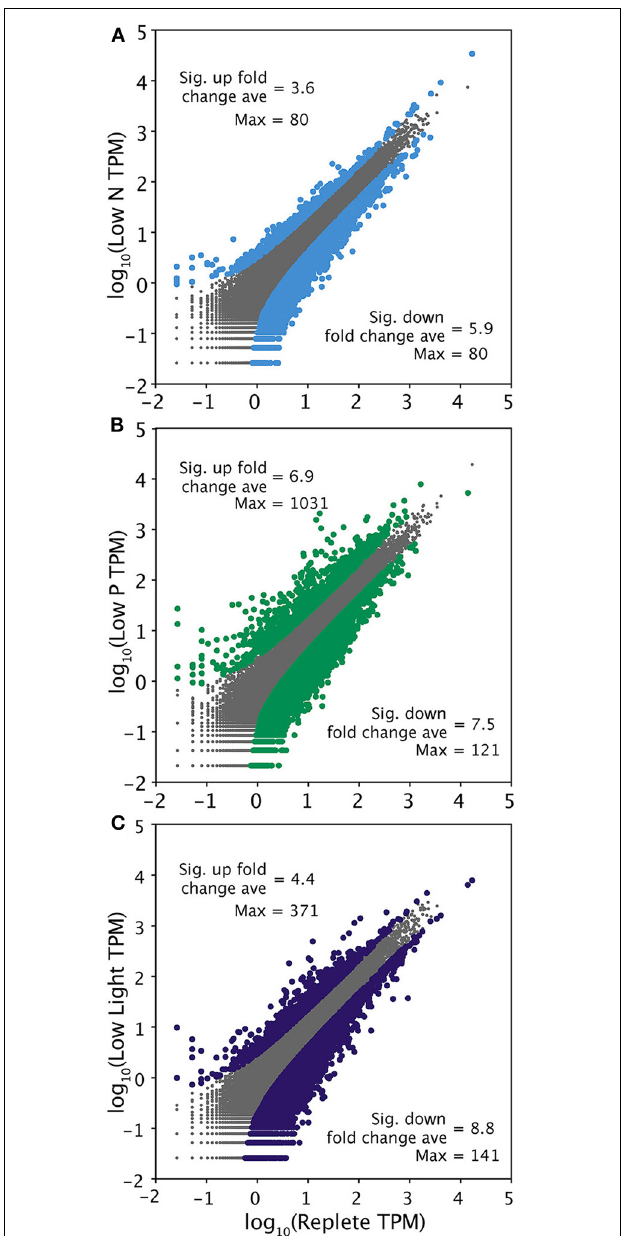
FIGURE 2 | Pairwise comparison of transcriptional responses across 37,314 contigs generated by a 90% clustering of the Trinity assembly in each treatment relative to the replete control. Transcriptome-side gene expression patterns are shown in low N (A) , low P (B) , and low light (C) . Transcripts were normalized to total library size in tags per million (TPM). Gray points represent transcripts that were not significantly differentially regulated. Significance (colored points) was determined with ASC using a fold change greater than or equal to 2 and a posterior probability greater than 0.95 (Wu et al., 2010). The average significant fold change and maximum fold change value of up and downregulated transcripts is